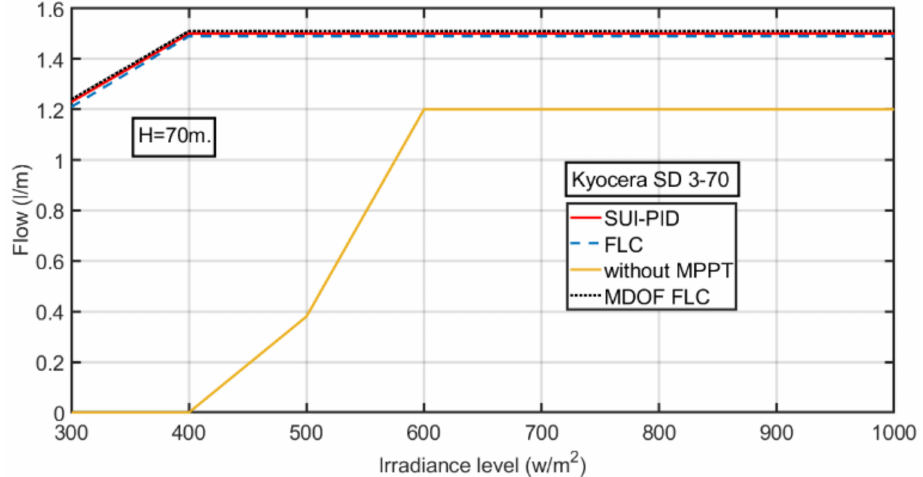
Figure 22. Performance analysis of the volume flow rate at a head of 70